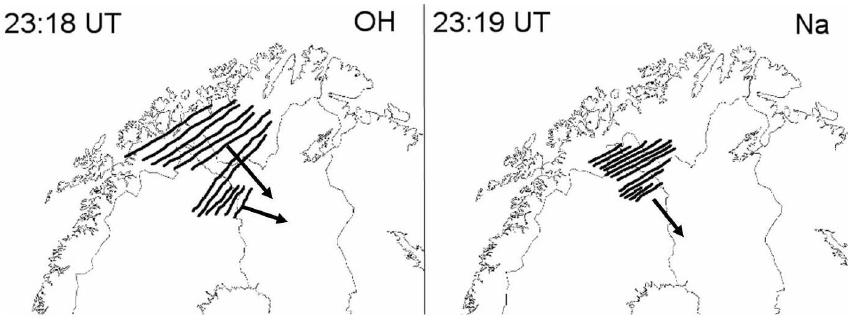
Fig. 18. Projected Esrange winds (left) and calculated m 2 (right) profiles for the January 29/30 event at 23:00 UT. The m 2 values are positive over the entire altitude range indicating a freely propagating wave.